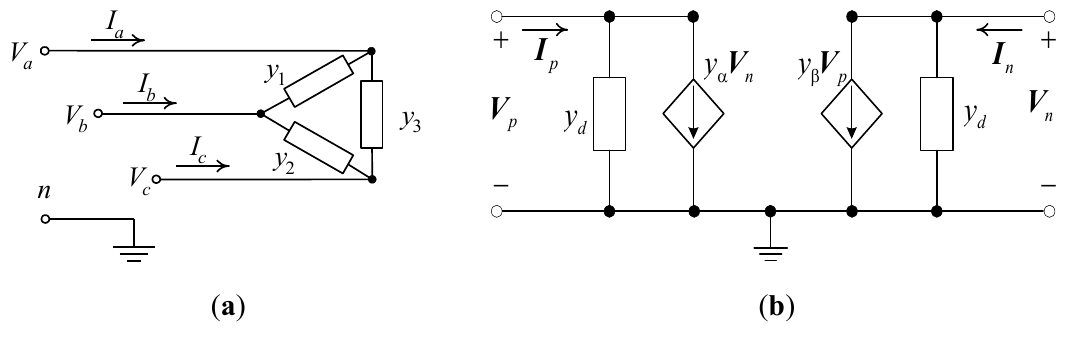
Figure 2. A delta-connected three-phase unbalanced load. ( a ) Circuit showing the nodal voltages and line currents; ( b ) The corresponding two-port network equivalent